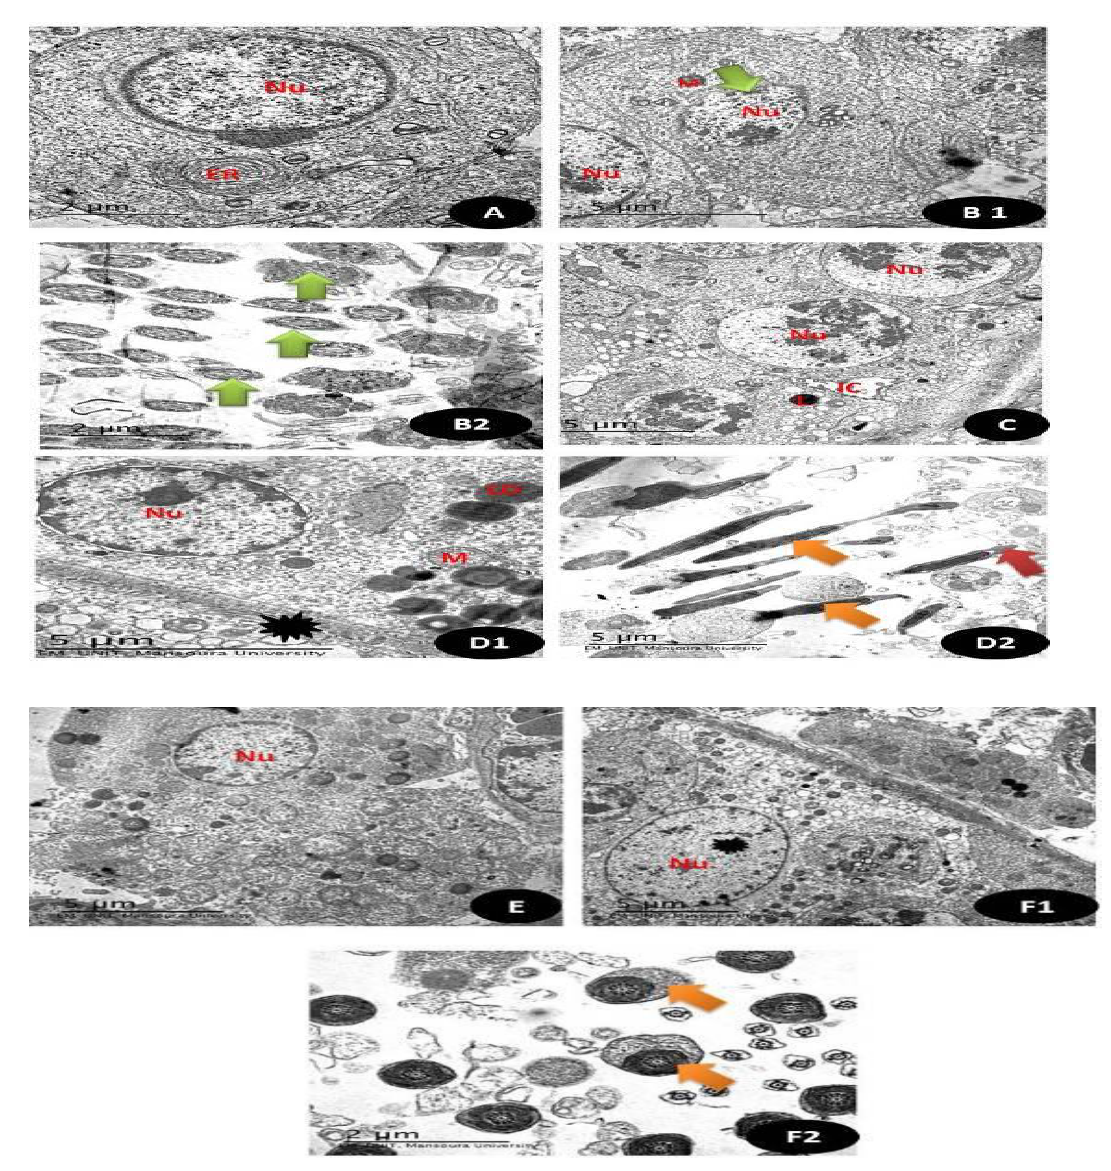
Figure 16. Transmission electron microscope of testis section showing in ( A ) Control group: normal appearance of spermatogonia (1ry and 2ry) with normal rounded nuclei (Nu) with normalLeydig cells (L) and normal myoid cells and normal endoplasmic reticulum (ER) are also noticed. (5 µ m). ( B1 , B2 ) TEM section of group treated with DG showing primary spermatocyte with irregular boundaries nucleus (Nu) with pyknotic nuclei with small sized mitochondria (M) and in (B2) there is distortion of the middle piece of the sperm with abnormal appearance (Green arrow) (5 µ m). ( C ) TEM section of Q treated group showing normal appearance of completed stages of spermatogenesis with appearance of normal euchromatin nucleus (Nu) with normal interstitial cells (IC) with Leydig cells (L) (5 µ m). ( D1 , D2 ) Ru III /Q treated group showing normal appearance of seminiferous tubules with normal appearance of nucleus (Nu) and normal sized mitochondria (M) with normal sized lipid droplets (LD) and normal myoid cell (Black star), (D2) showed normal sperm sheath (Orange arrow) with intact acrosomal cap (Red arrow) (5 µ m). ( E ) TEM sections of DG + Q treated group showing restoration of nuclear boundaries (Nu) with incomplete spermatogenic layers with restoration of sperms (5 µ m). ( F1 , F2 ) TEM section of DG treated with novel complex of Ru III /Q showing restoration of normal composition of seminiferous tubules with appearance of normal rounded nucleus (Nu) (Black star) with normal appearance of myoid cells with complete stages of spermatogenic cells (5 µ m), (F2) showing normal sized sperm middle piece with complete tubules (Orange arrow) (2 µ